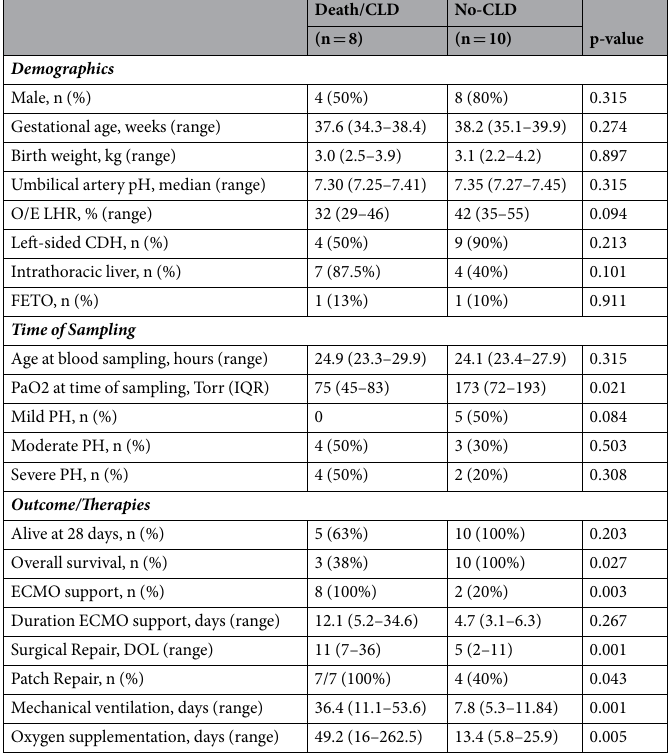
Table 1. Sample demographics and clinical characteristics. CLD: chronic lung disease, O/E: observed vs. expected, LHR: lung-to-head ratio, FETO: fetoscopic endoluminal tracheal occlusion, IQR: interquartile range, PH: pulmonary hypertension, ECMO: extracorporeal membrane oxygenation, DOL: day of